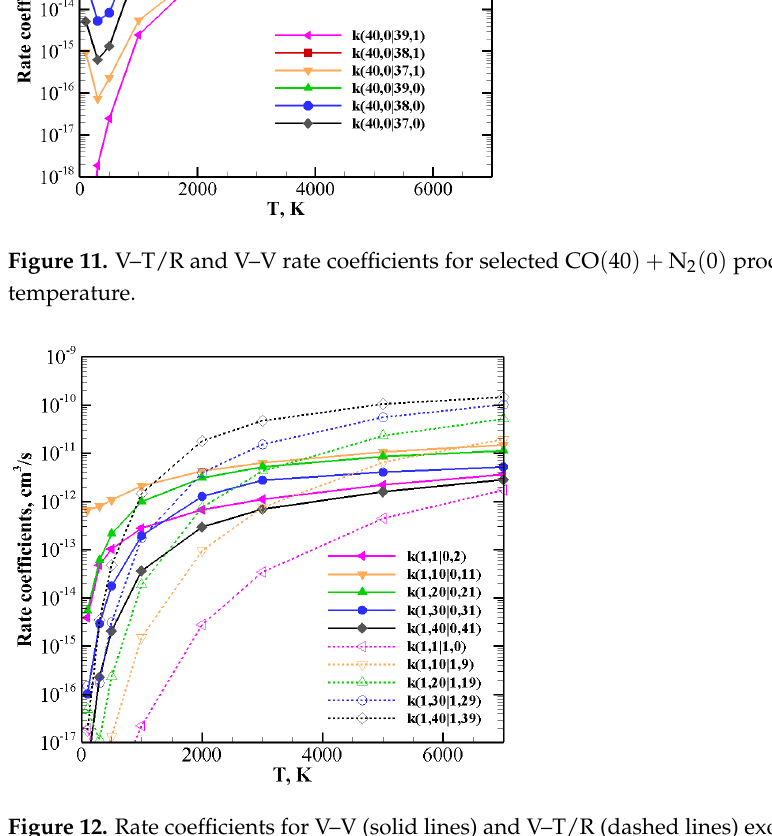
Figure 12. Rate coefficients for V–V (solid lines) and V–T/R (dashed lines) exothermic processes for CO(1) + N 2 ( v ) collisions.